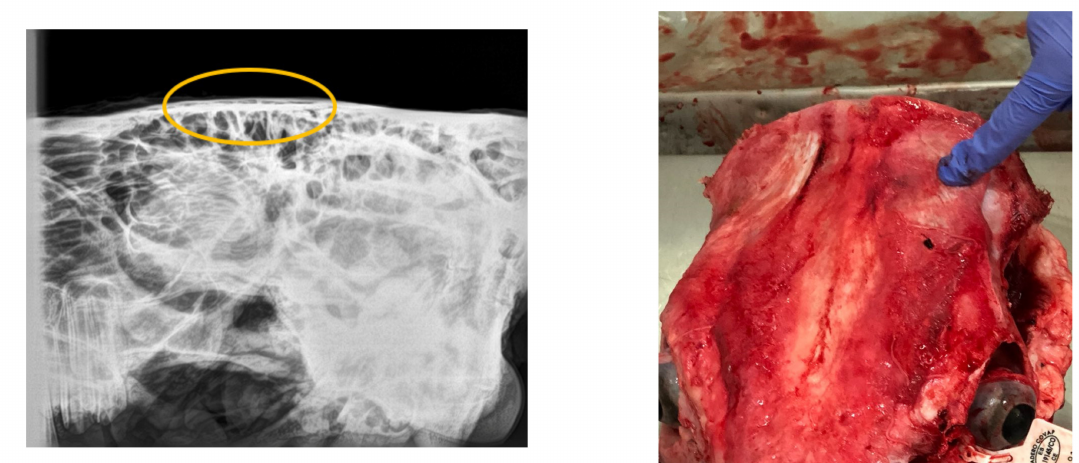
Figure 4. Digital radiography rating 2 (following Malaysia Standard 1500:2009), and related